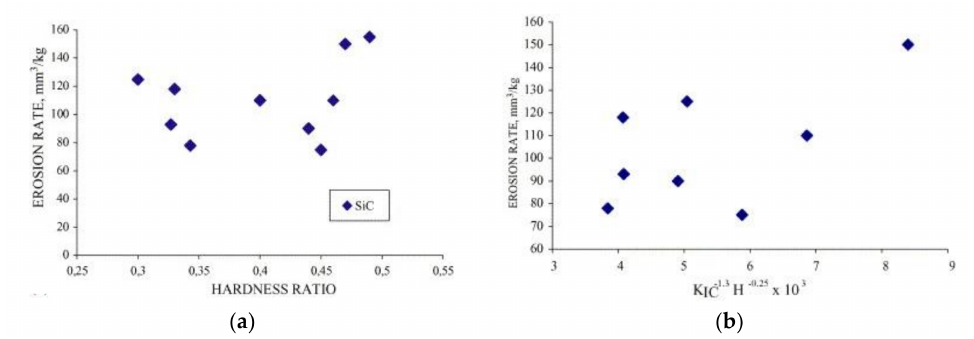
Figure 11. Erosion rate vs. hardness ratio H m /H a ( a ) and K IC − 1.3 H m − 0.25 ( b ) for the WC-, TiC- and Cr 3 C 2 -based composites (erodent SiC 0.1–0.3 mm, particles velocity 60 m/s, attack angle α = 75 ◦ )